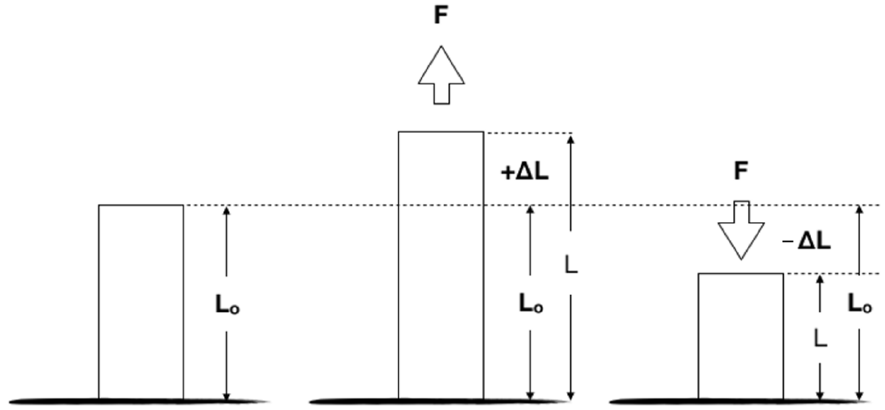
Figure 7. Illustration showing the positive (tensile) and negative (compression) strain of material. The strain gauge sensors are arranged in an electrical circuit, the Wheatstone bridge, capable of measuring the variation in electrical resistance. This bridge can have different configurations, including ¼ bridge, ½ bridge, ½ diagonal bridge, and complete bridge. When ¼ of the Wheatstone bridge is used, it is formed by four resistors (R1, R2, R3, and R4) with direct or alternating voltage. If the resistance values are the same (R1 = R2 = R3 = R4) and an input voltage (Vin) and an output voltage (Vout) are connected to the circuit, there will be no potential difference (DDP) (Figure 8) [30].